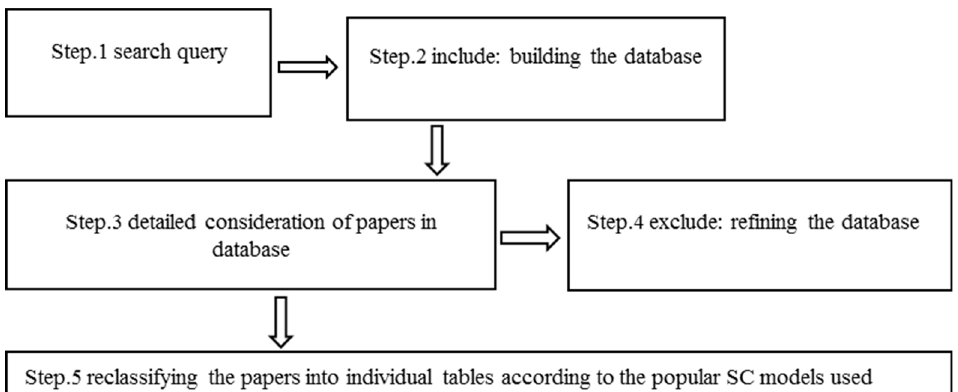
Figure 2. Methodology of research.